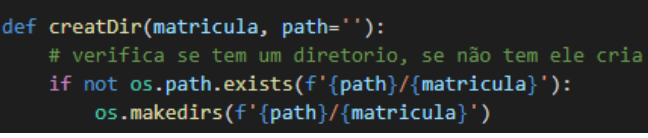
Figure 9: Image bank directory creation function.